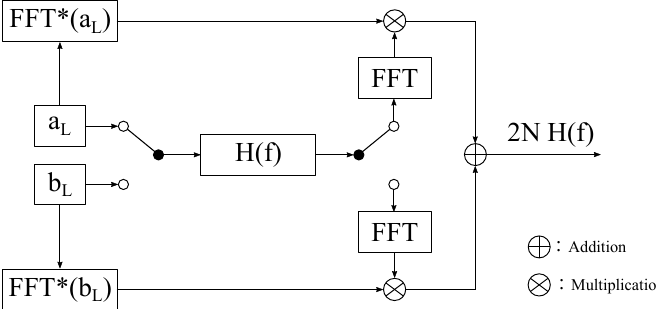
Figure 5. System identification using a pair of Golay codes (adapted from Figure 2 in